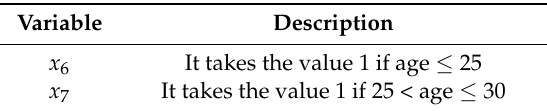
Table 8. Binary variables used for the segmentation of the age.